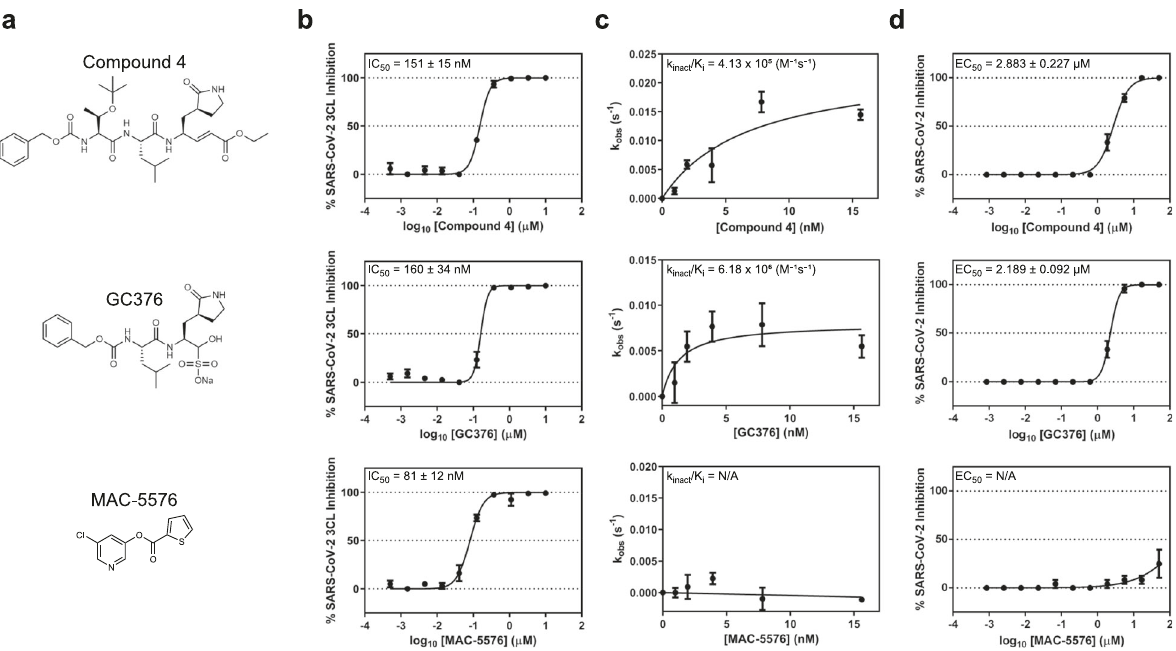
Fig. 2 Inhibition of SARS-CoV-2 3CL protease by compound 4, GC376, and MAC-5576. a Chemical structures of the three compounds in this study. b Inhibition of puri fi ed native SARS-CoV-2 3CL protease by each compound. c Kinetics of inhibition of SARS-CoV-2 3CL protease by each compound. d Inhibition of SARS-CoV-2 viral replication by each compound. Data are shown as mean ± s.e.m. for two or three technical replicates for b , two technical replicates for c , and for three technical replicates for d . IC 50 and EC 50 values denote mean ± s.e.m. for two independent biological